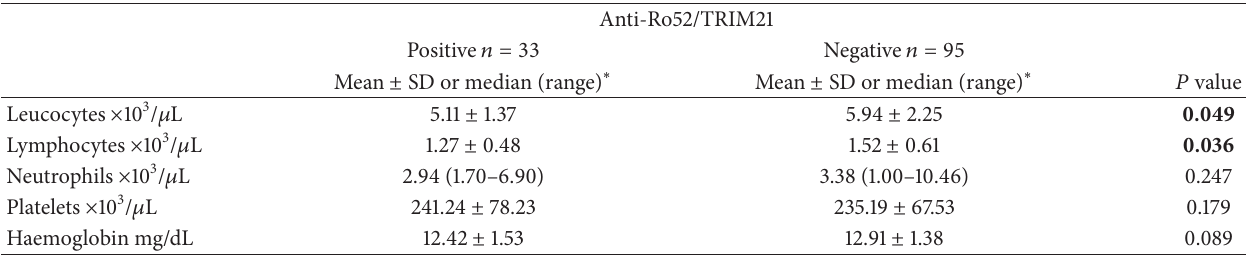
Table 4: Haematological parameters according to the anti-Ro52/TRIM21